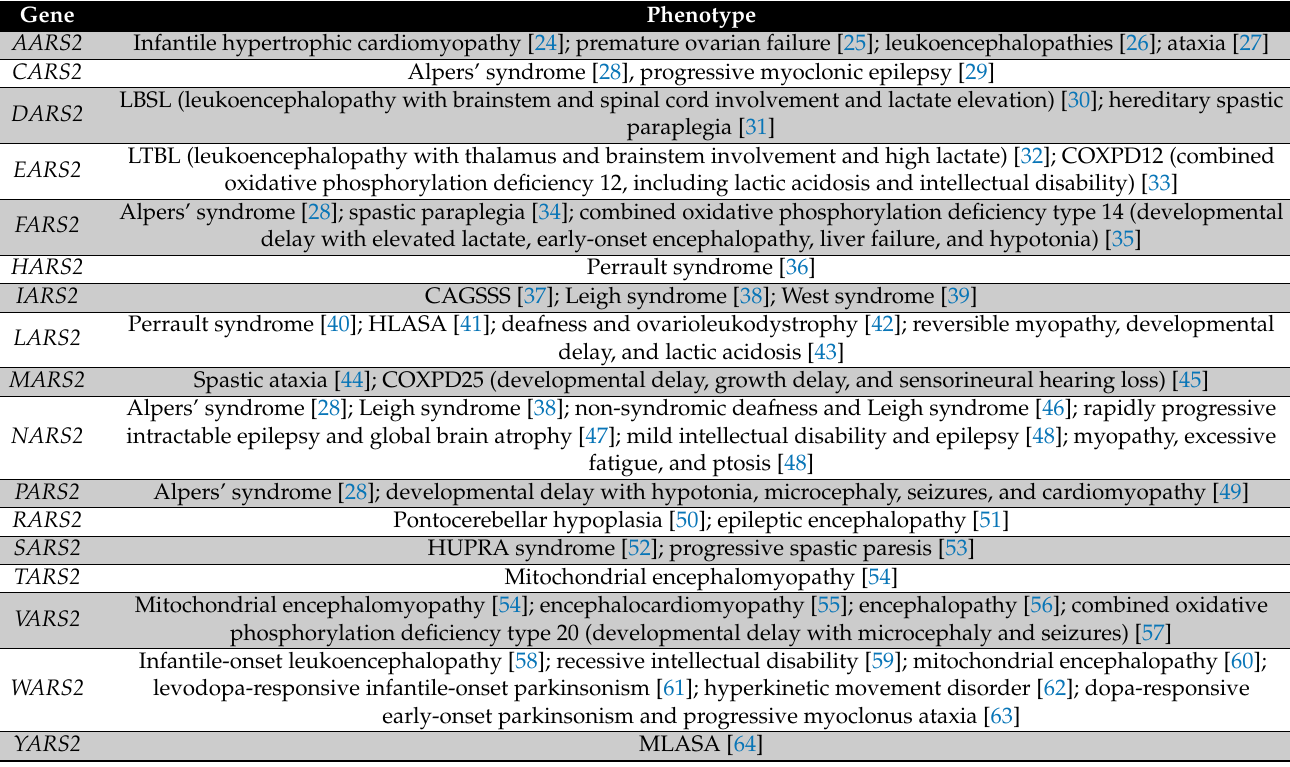
Table 1. mt-ARS genes and associated clinical phenotypes. Acronyms not defined here (CAGSSS, HLASA, HUPRA, and MLASA) are defined in the body of the